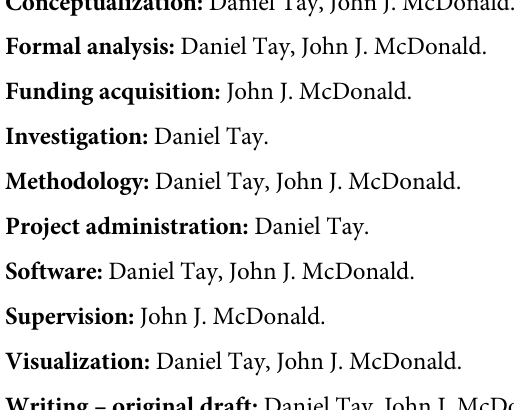
of singleton-present displays.